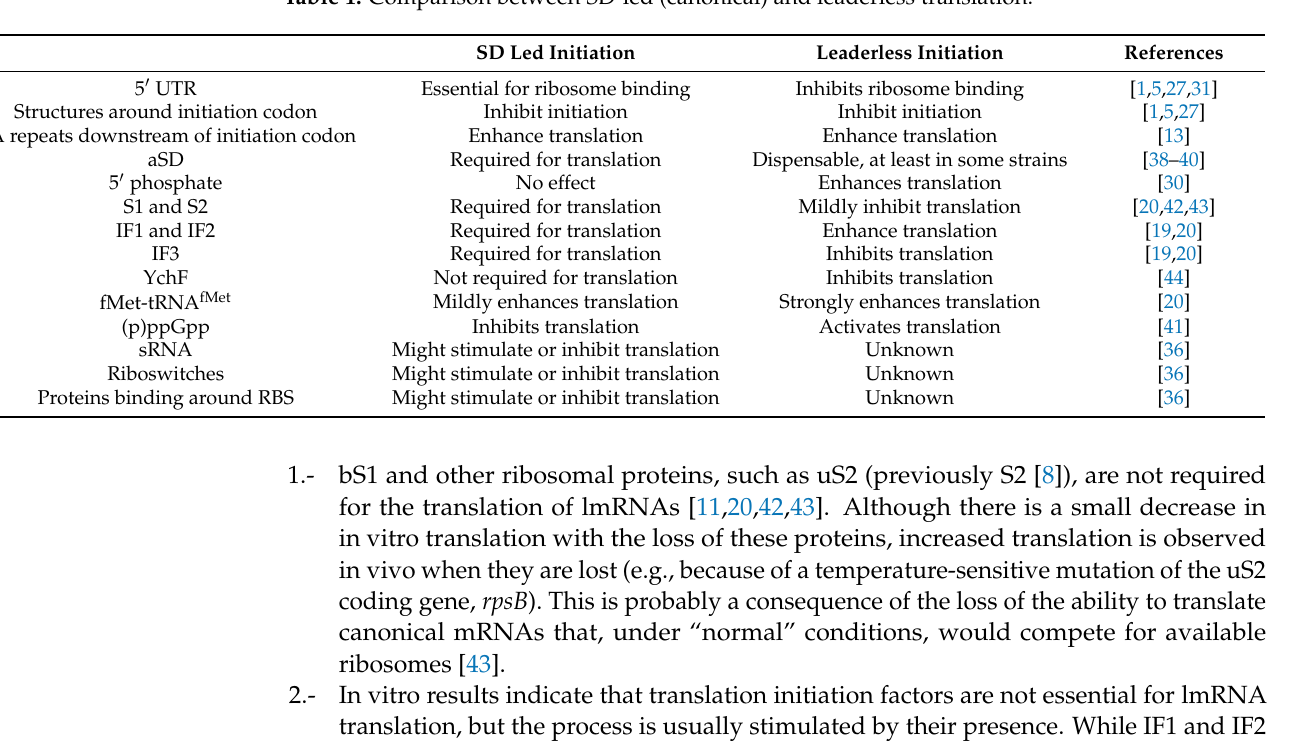
Table 1. Comparison between SD-led (canonical) and leaderless